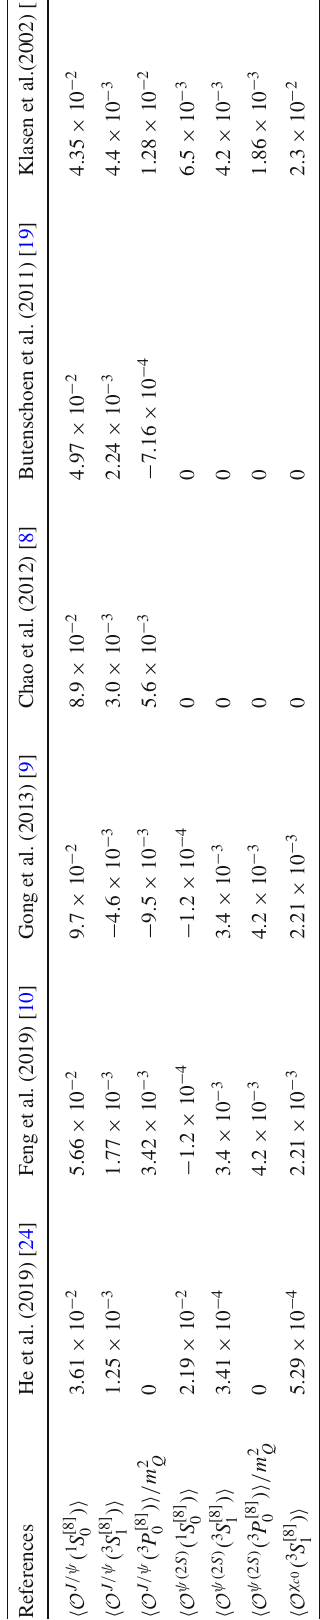
where θ is the angle between J /ψ and beam. Both cos θ and y distribution are calculated under the cut condition p t ≥ 0 . 01 GeV. We vary μ r and μ f from μ 0 / 2 to 2 μ 0 to estimate the theoretical uncertainties. When taking μ r = μ f and varying them simultaneously, we find their uncertain- ties cancel with each other to some degree. So we vary them independently and the largest uncertainties is obtained